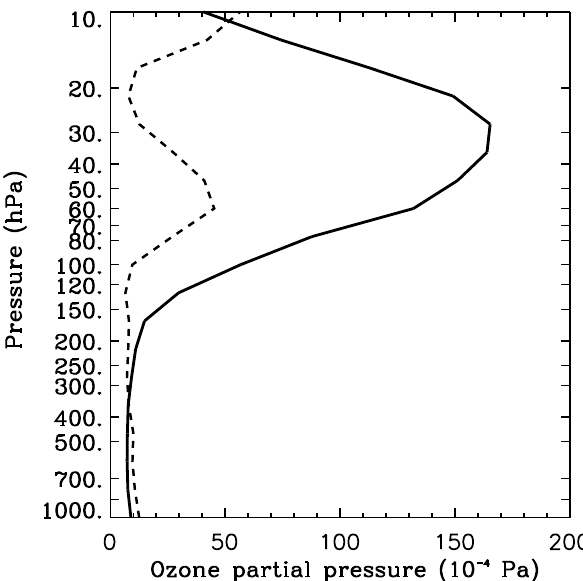
Fig. 10. Modeled ozone profiles near the South Pole for a single day in August (solid line) and in October (dotted